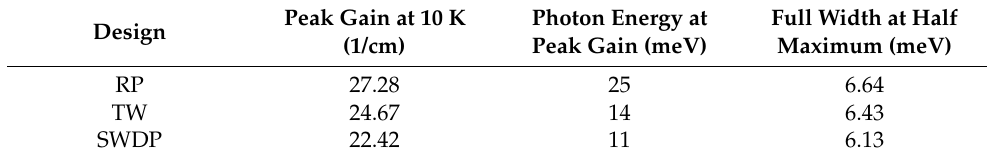
Table 2. Gain data for the three designs.